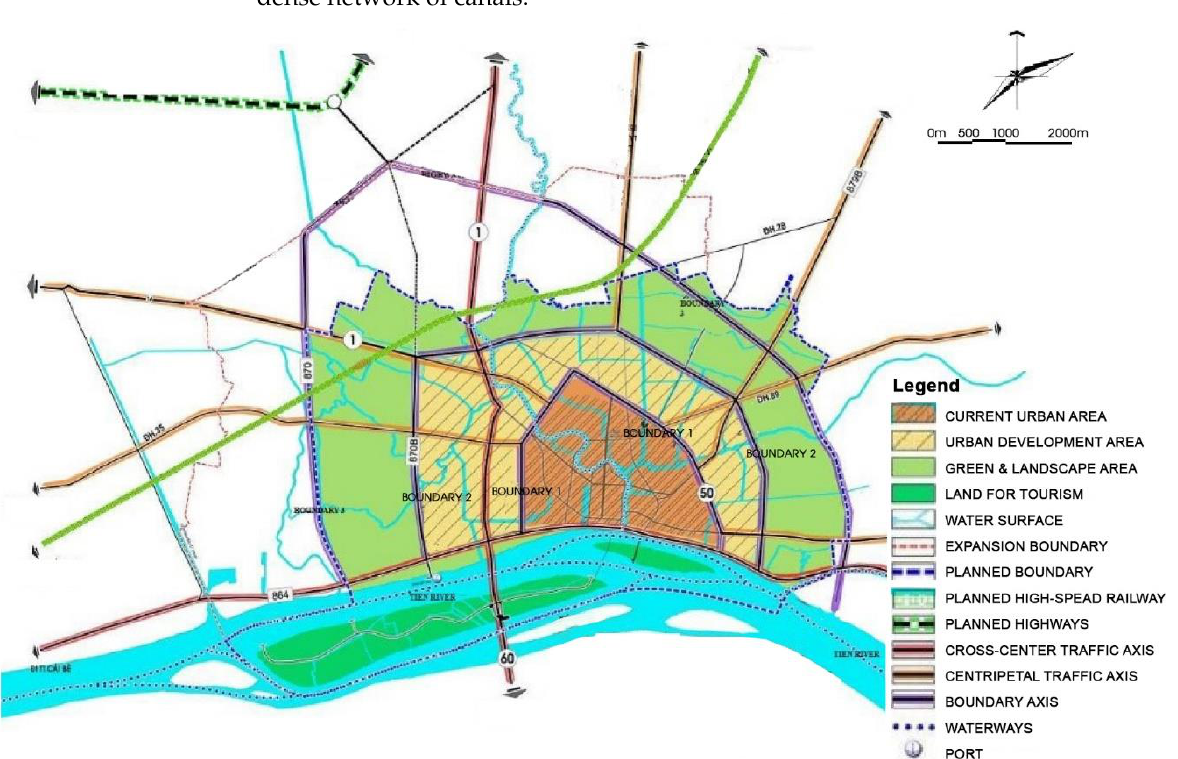
Figure 9. The analysis diagram of MTC’s landscape structure including the existing urban area, the urban development area, and the local agricultural landscape. My Tho has an interlaced system of rivers and canals located in the heart of the city, associated with the islet system on Tien River, creating a unique feature for this urban area. Source: Adapted from SISP.